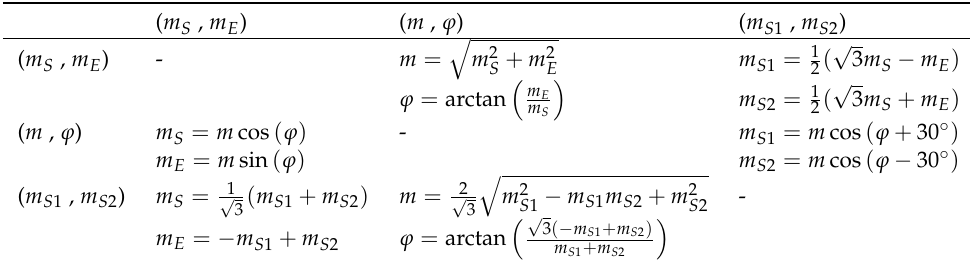
Table 1. Conversion formulae between variables used in different descriptions of the stress state of a